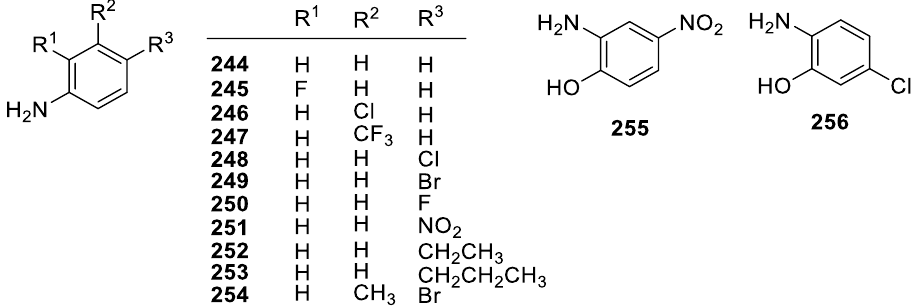
Figure 18. Structure of anilines studied in a comparative study with phenols.